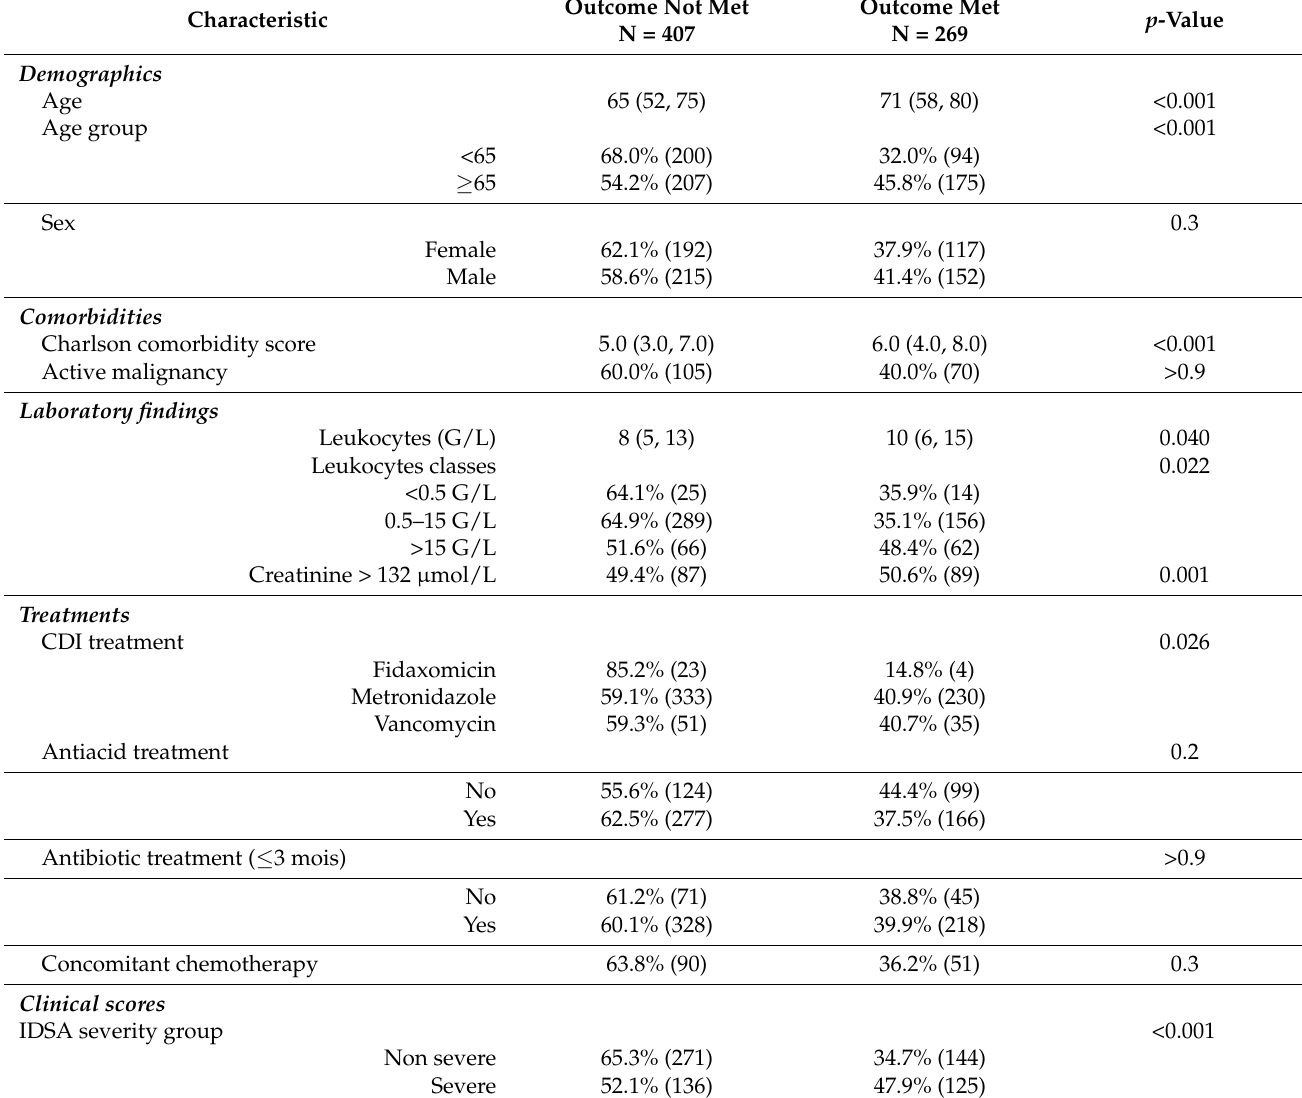
Table 2. Univariate analysis of factors associated with composite